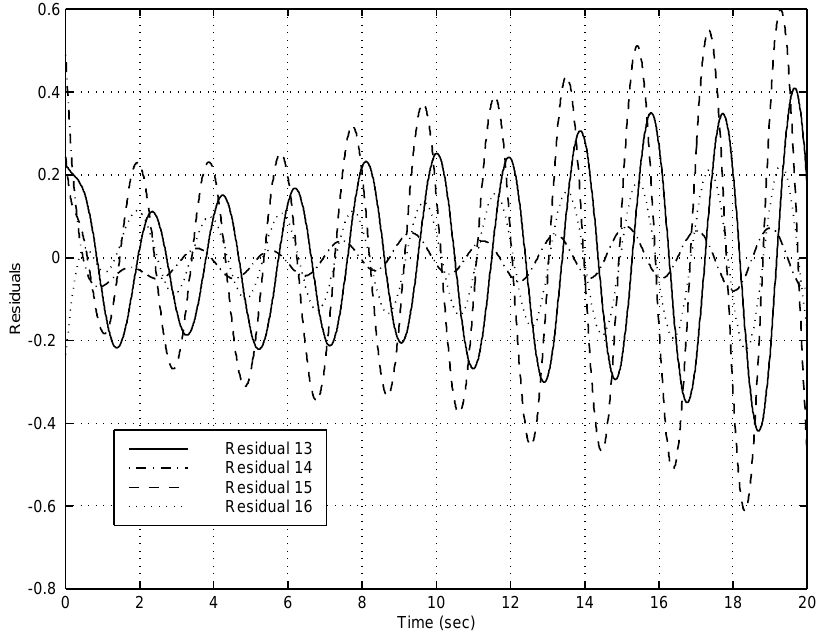
Fig. 6. Residuals 13–16 for 8 mode simulation with δ 1 = 0 . 005